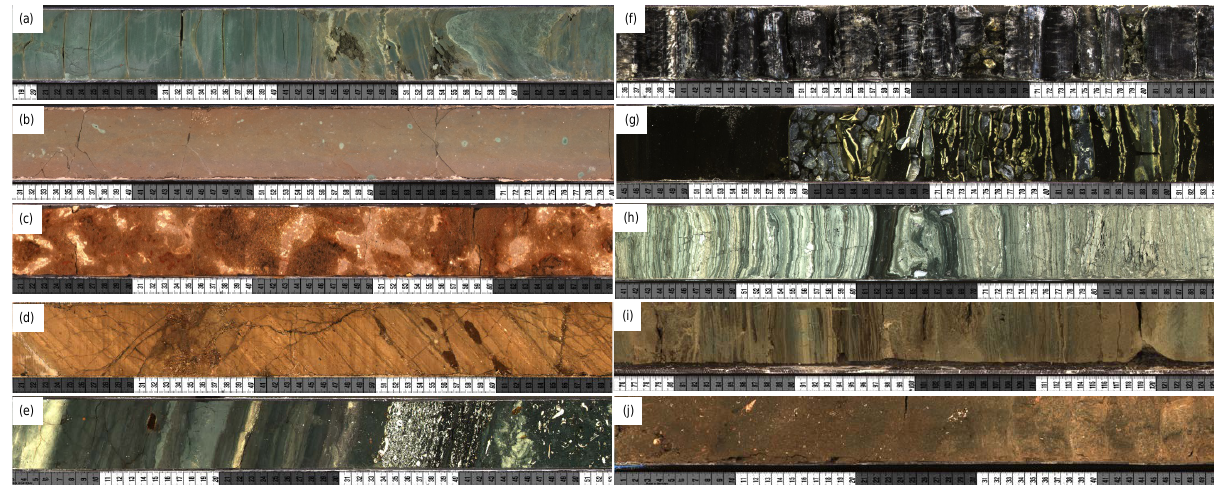
Figure 7. Representative lithologies found in HSPDP drill cores. Positions of each photo within the cores are indicated on the respective summary stratigraphy diagrams. NAO14-1B-66Q-1 (154.66–155.07m below surface – mb.s.) from the Northern Awash Oso Isi site, northern Ethiopia. Note: many coring gaps in NAO14-1B are infilled by matching to the twinned borehole NAO14-1D (not illustrated), collected im- mediately adjacent to this core. Laminated green lake clays with soft sediment deformation. NAW14-1A-71Q-2 (138.60–139.06mb.s.) from the Northern Awash Woranso site. Massive brown, silty, diatomaceous clay. BTB13-1A-52Q-2 (150.21–150.71mb.s.) from the Baringo- Tugen Hills site, central Kenya. Well-developed paleosol with carbonate nodules. BTB13-1A-3Q-1 (9.85–10.35mb.s.) from the Baringo- Tugen Hills site. Laminated diatomite with carbonate interbeds. WTK13-1A-63Q-1 (150.16–150.66mb.s.) from the West Turkana drill site, northern Kenya. Green silty clays with mollusc coquinas. MAG14-2A-9Y-1 (19.58–20.08mb.s.) from Lake Magadi, southern Kenya. Interbedded trona and thin muds. MAG14-1A-49Y-1 (75.02–75.52mb.s.) Interbedded black silty clay and yellow/black chert. MAG14-2A- 67Y-1 (147.10–147.60mb.s.) from Lake Magadi. Laminated muds. CHB14-2A-35A-2A (73.22–73.72mb.s.) partly laminated green and brown muds from the Chew Bahir Basin. CHB14-2A-70Q-1A (146.58–147.05mb.s.) brown, mollusk-bearing massive mudstones from the Chew Bahir